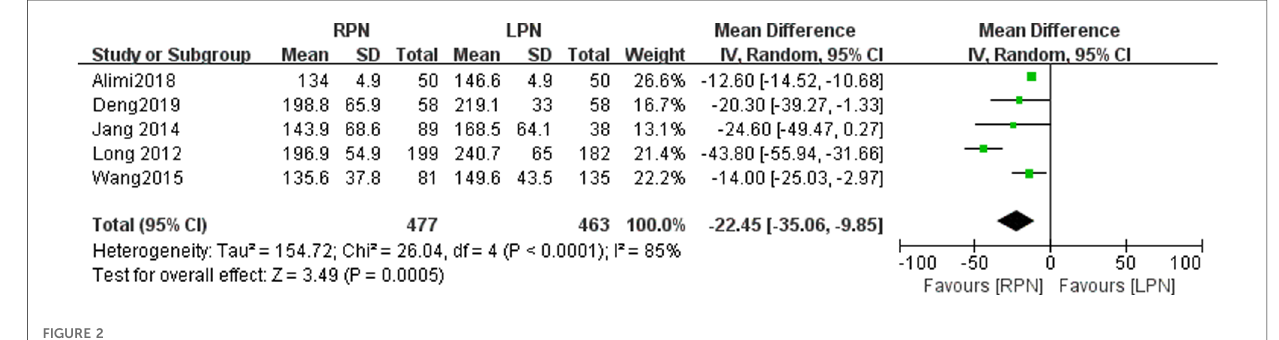
FIGURE 2 Forest plot for operating time between the RPN and LPN.